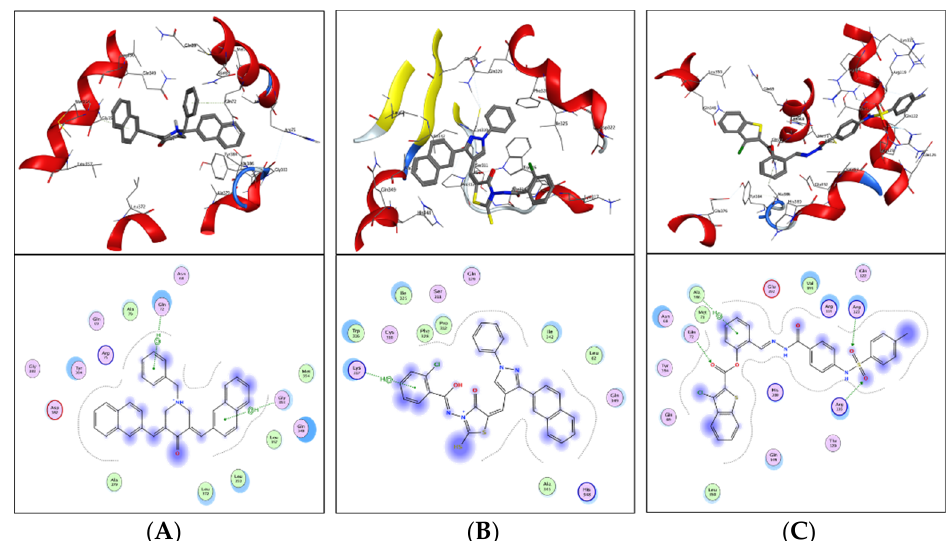
Figure 8. Molecular docking. Molecular docking analysis for the shortlisted compounds ( A ) ZINC20115475, ( B ) ZINC02688148, and ( C ) ZINC04231816. The ZINC04232055 was found to mediate four hydrogen bonds as hydrogen accep- tors with Gln72, Ala386, Arg123, and Arg119. It resulted in binding energy of − 8.6 kcal/mol (Figure 9A).